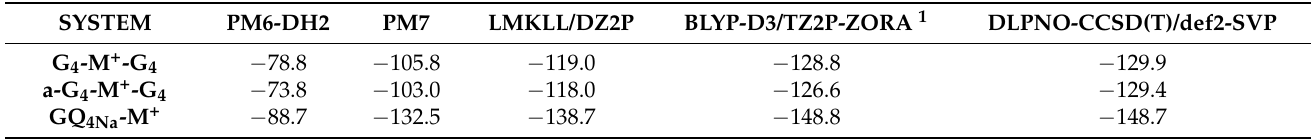
Table 2. Interaction energies for different systems taken from the work of Fonseca Guerra et al. [144] consisting on G-tetrads interacting with alkali cations at DLPNO/CCSD(T)/def2-SVP, LMKLL/DZ2P, BLYP-D3/TZ2P-ZORA, PM6-DH2 and PM7 level.